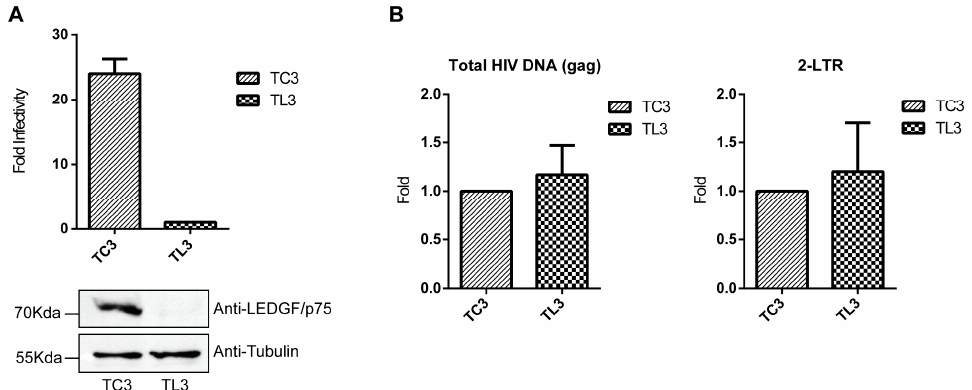
Figure 1. HIV-1 infection of control (T C3 ) and lens epithelium-derived growth factor (LEDGF/p75)- deficient (T L3 ) cells. ( A ) Single-round infection of T C3 and T L3 cells. Cells were challenged with HIVluc and luciferase activity was analyzed 5 days post-infection. Luciferase levels detected in T L3 cells were used for normalization. Bars represent the mean and standard deviation values calculated from 4 independent infection experiments performed on different days with different viral preparations. Levels of LEDGF/p75 were determined by immunoblotting with a specific antibody against LEDGF/p75. Equal protein loading was accessed by immunoblotting with anti-Tubulin; ( B ) real time PCR quantification of total HIV cDNA (gag DNA) and circularized HIV-1 cDNA containing two long terminal repeats (2-LTRs) isolated from HIVluc-infected T C3 and T L3 cells. Bars represent the mean and standard deviation of values calculated from 2 independent infection experiments. Levels found in T C3 cells were used for normalization.